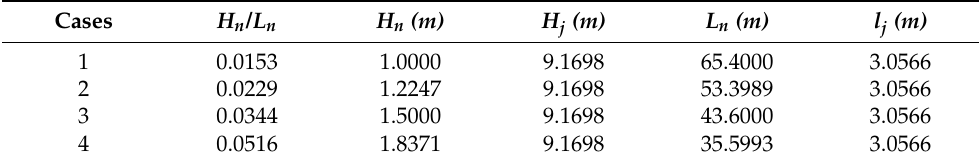
Table A1. Geometric variation in hydropneumatic